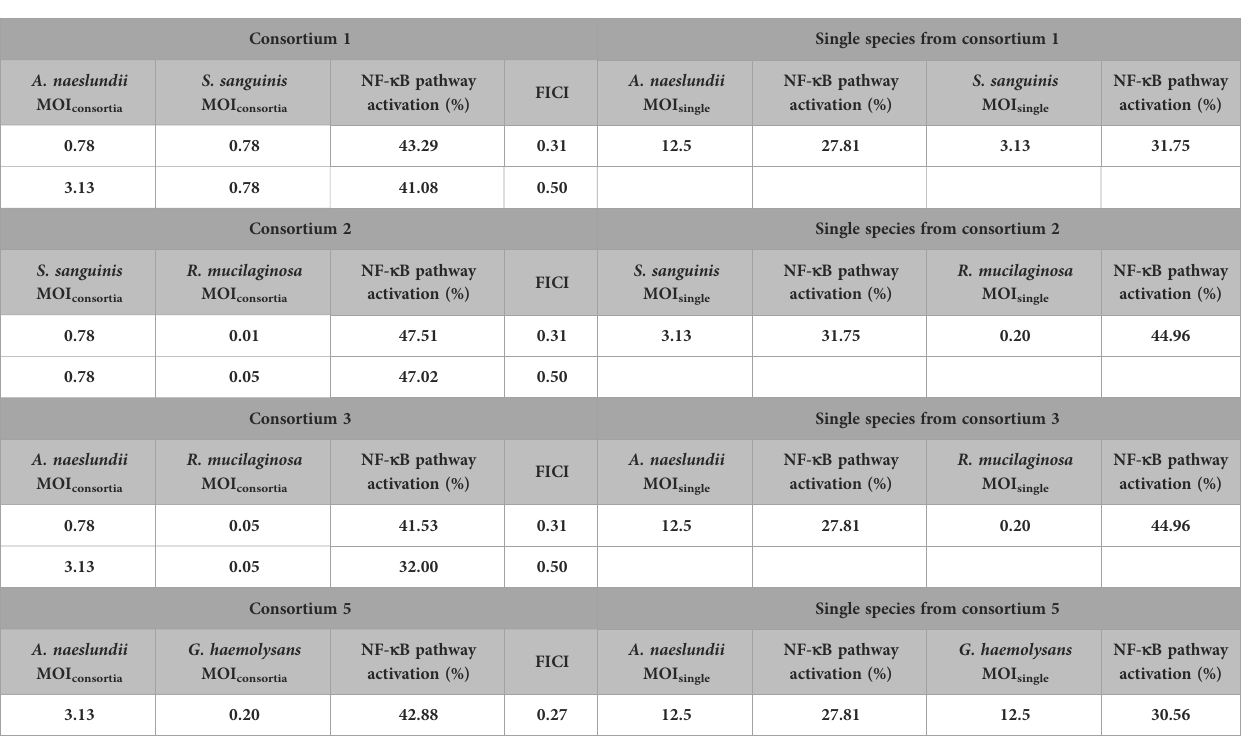
TABLE 2 Synergistic consortia and single species with corresponding MOI ratios, NF- k B pathway activation compared to LPS-stimulated cells and FICI values.